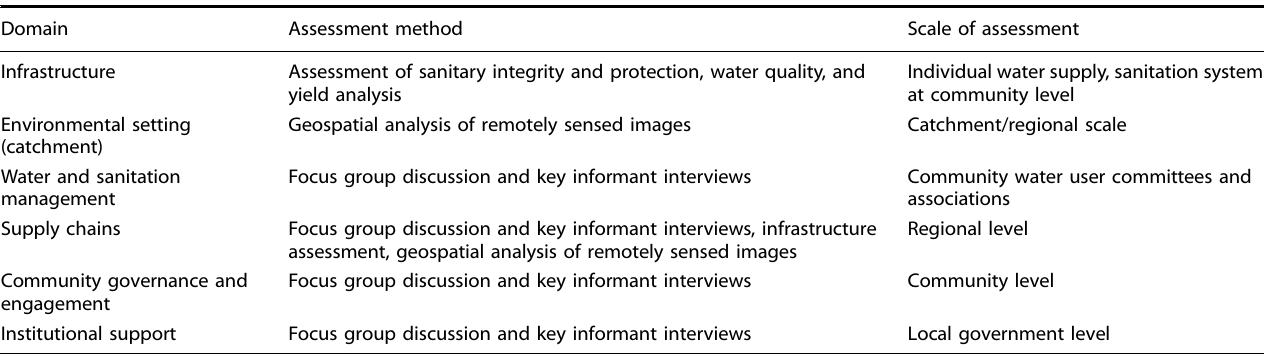
Table 1. Domains of resilience for application to